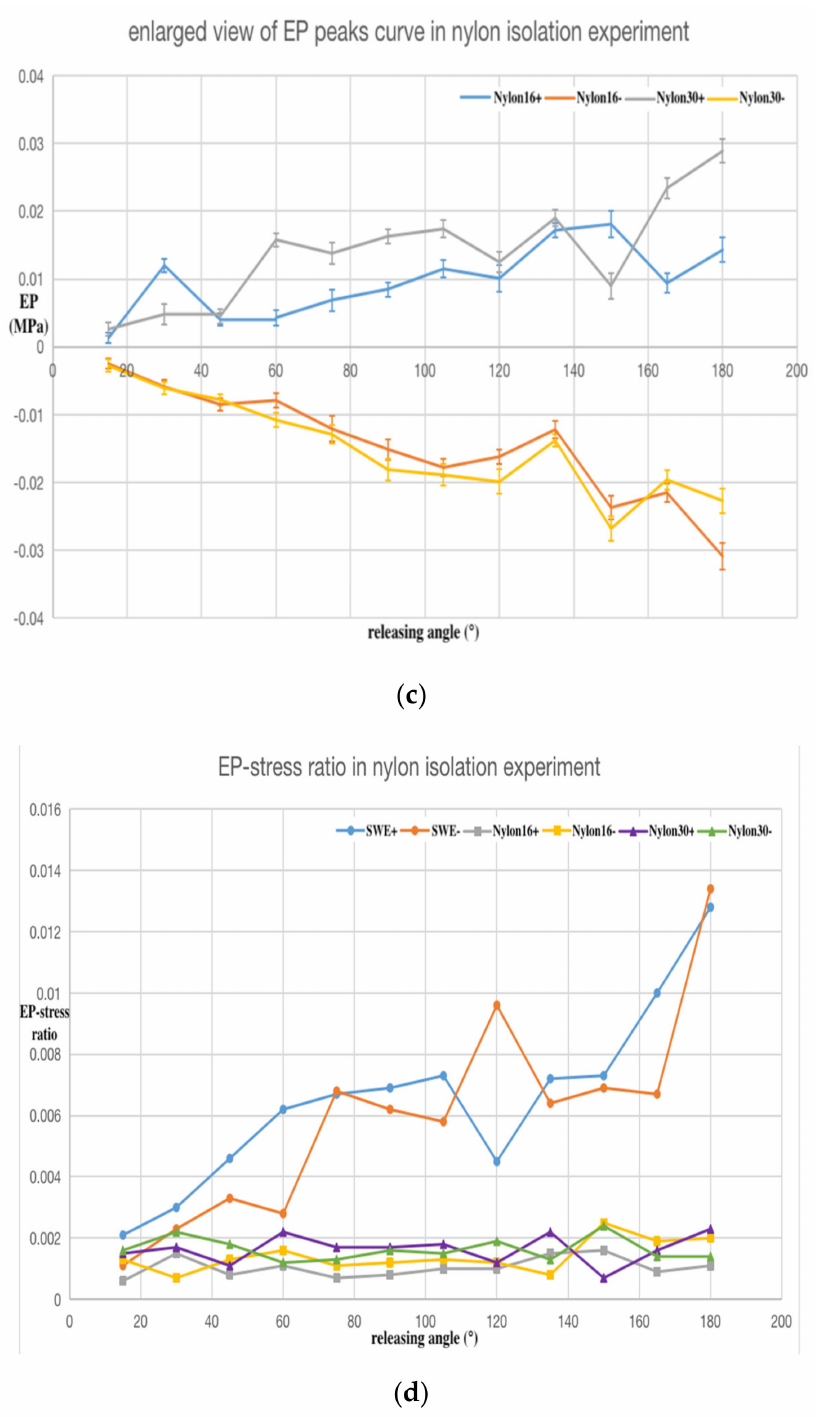
Figure 9. Analysis results of the nylon isolation pedestal experimental data: ( a ) stress; ( b ) EP of the PPS output; ( c ) larger view of (b); ( d ) EP–stress ratio. The ordinate unit of (d) is